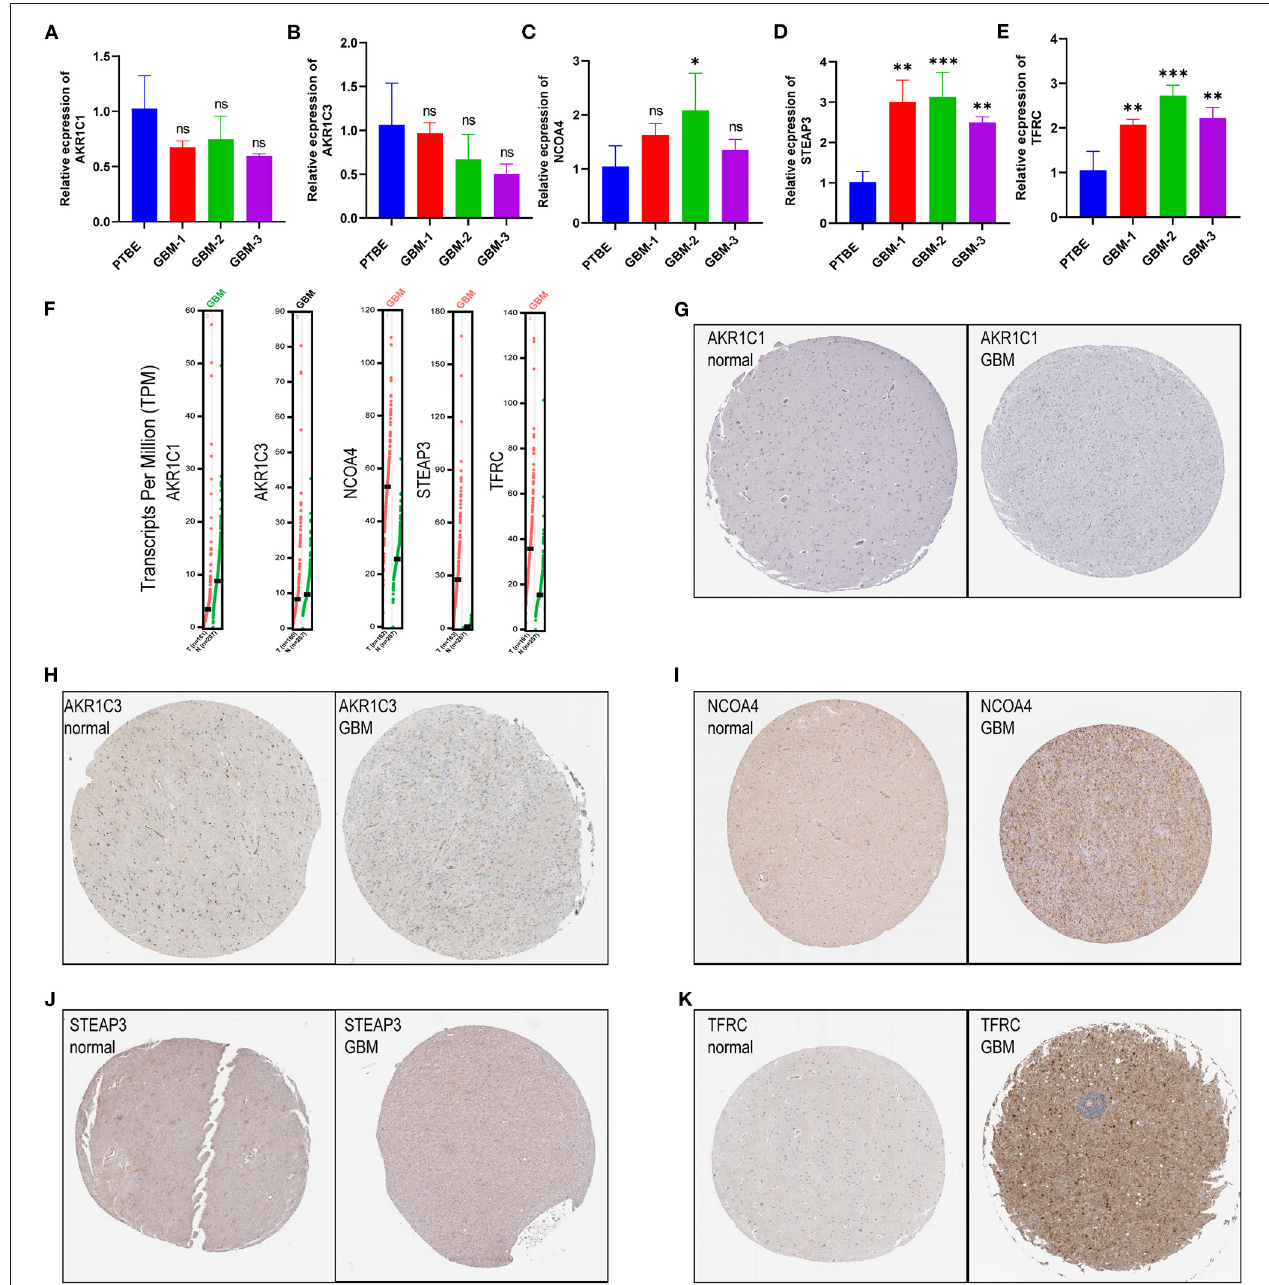
FIGURE 8 | Validation of risk genes (A–E). (A) AKR1C1, (B) AKR1C3, (C) NCOA4, (D) STEAP3, and (E) TFRC expression in peritumoral brain edema and GBM tissues. (F) The expression of prognostic model with five genes (NCOA4, TFRC, STEAP3, AKR1C1, and AKR1C3) in GEPIA. (G–K) Validation of five genes with immunohistochemistry from the HPA